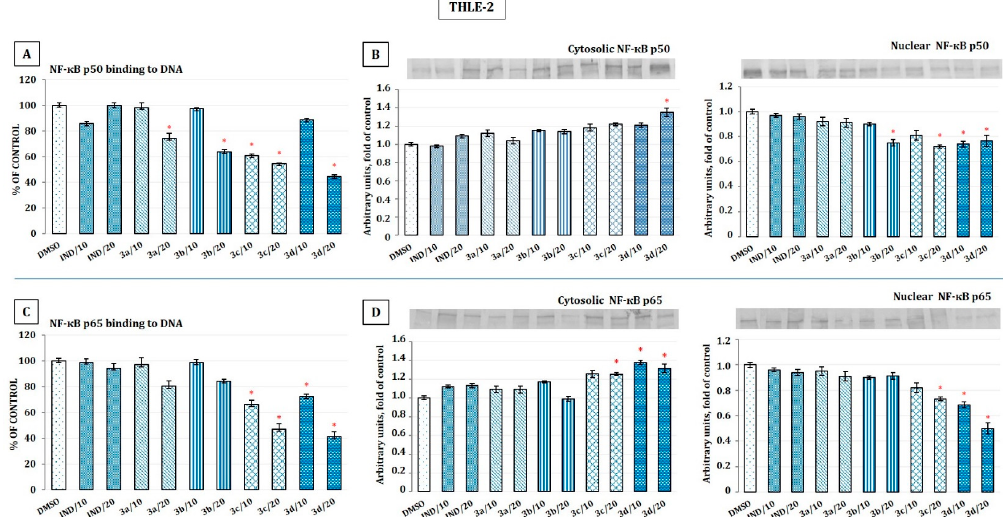
Figure 5. The effect of IND and OAO–IND derivatives ( 3a, 3b, 3c, and 3d ) on the NF- κ B p50 and NF- κ B p65 binding to DNA ( panels A,C ) and translocation from cytosol to nuclei in THLE-2 cells ( panels B,D ). Activated NF- κ B p50 and NF- κ B p65 were assessed in terms of the amount of NF- κ B p50 ( panel A ) and NF- κ B p65 ( panel C ) contained in the DNA-binding complexes extracted from the nuclear fraction. The values (means ± SEM) were calculated from three sep- arate experiments as protein level in comparison with control cells (expression equals 100%). Representative immunob- lots for the analysis of the cytosolic and nuclear levels of proteins NF- κ B p50 ( panel B ) and NF- κ B p65 ( panel D ) are shown. The sequence of the bands corresponds to the sequence of the bars in the graph. The values were calculated from three separate experiments as protein level in comparison with control cells (expression equals 1). * Significantly different from DMSO (control)-treated cells, p < 0.05.